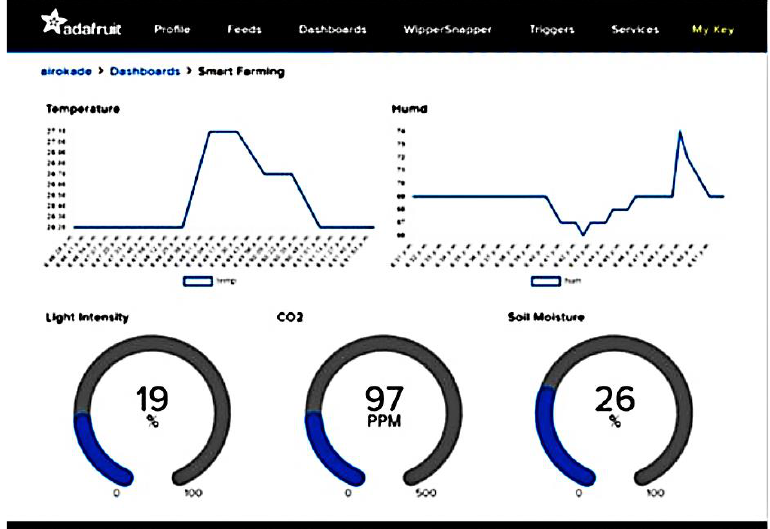
Figure 9. Sensor output on Adafruit IO Cloud IoT dashboard for Case 1.